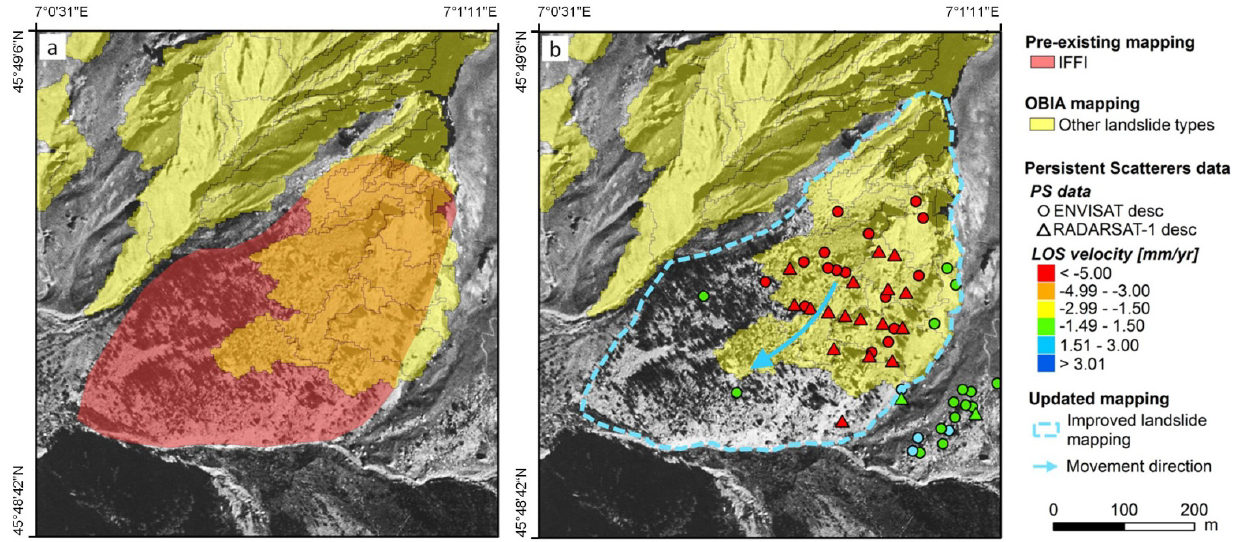
Figure 12. Integrated landslide mapping in the Sapin valley area updating the IFFI pre-existing inventory ( a ) through the OBIA approach and ( b ) complemented through radar-interpretation of ENVISAT (2004–2009) and RADARSAT-1 (2005–2009) descending PS data. Landslide mapping and PS data are overlapped on the 1998–1999 orthophoto, displayed using grey scale. Negative velocity values for the identified PS represent LOS movements in the direction away from the sensor, while positive values represent movements towards the satellite